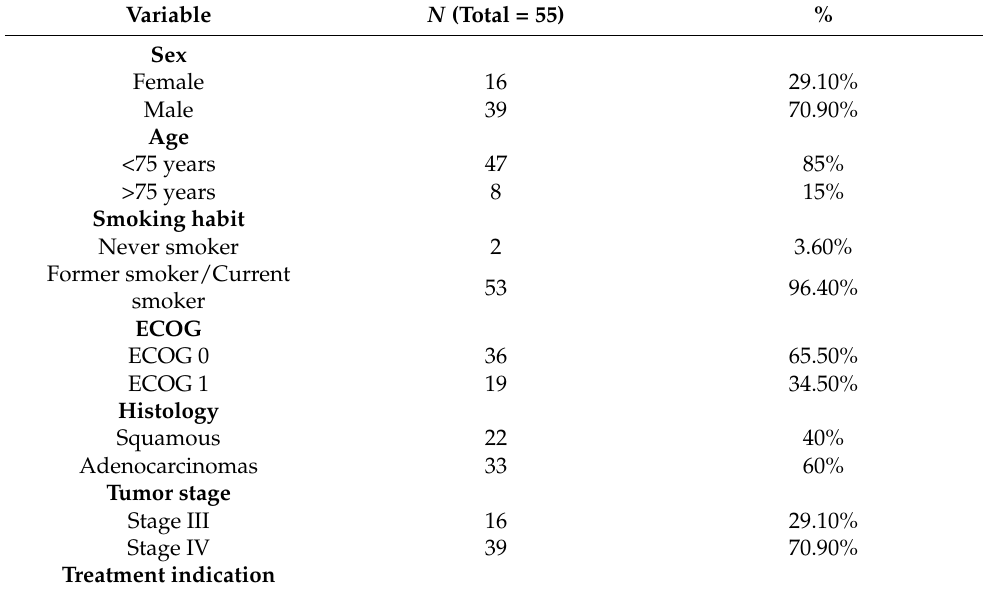
Table 1. Population basal